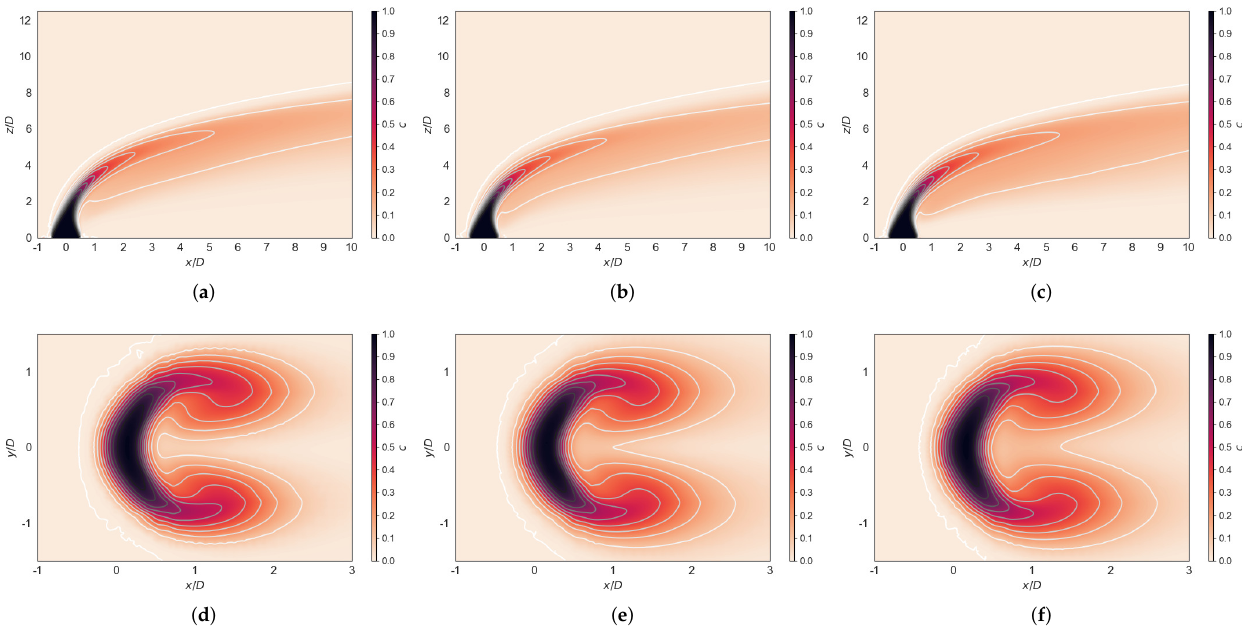
Figure 9. Two–dimensional plots of the scalar c at y / D = 0 (top) and z / D = 1.5 (bottom) for cases that employed the AMR approach: ( a , d ) k − (cid:101) model; ( b , e ) k − ω TNT model; ( c , f ) k − ω SST model.